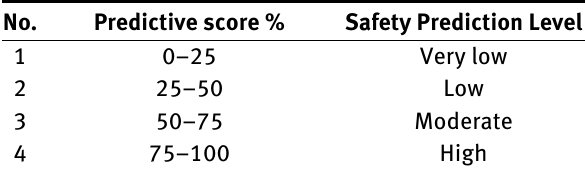
Table 2: Safety compliance level and its predictive